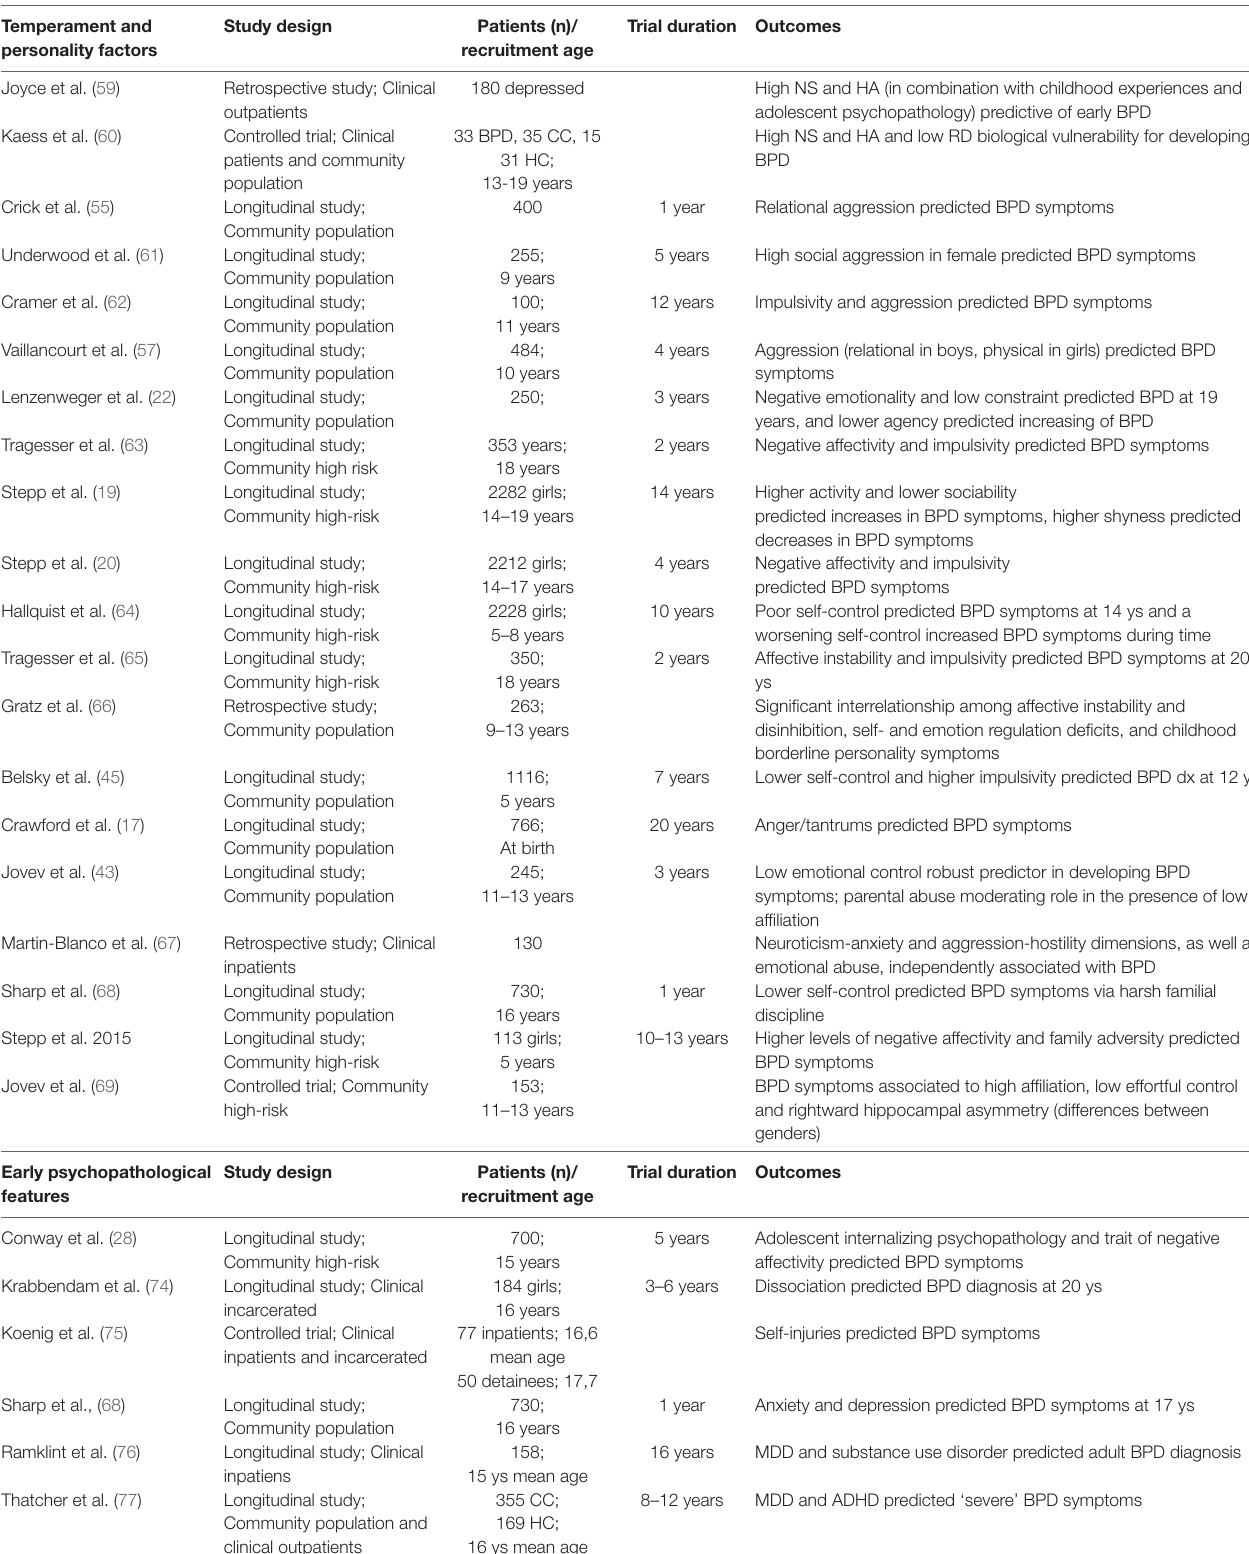
TABLE 2 | Summary of studies on child and adolescent temperament and personality factors and early psychopathological